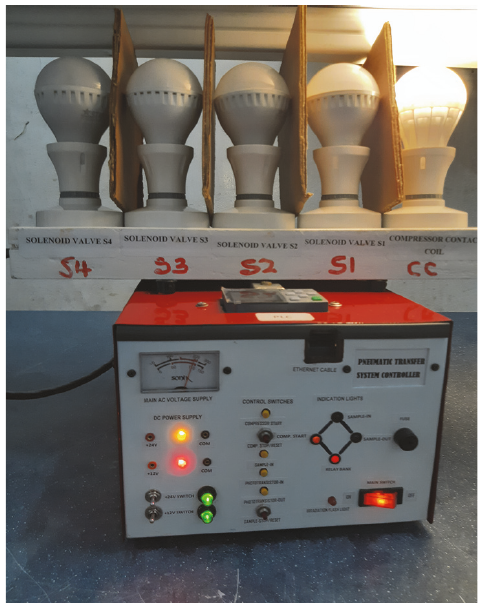
Figure 14: Contactor coil energized, compressor starts.